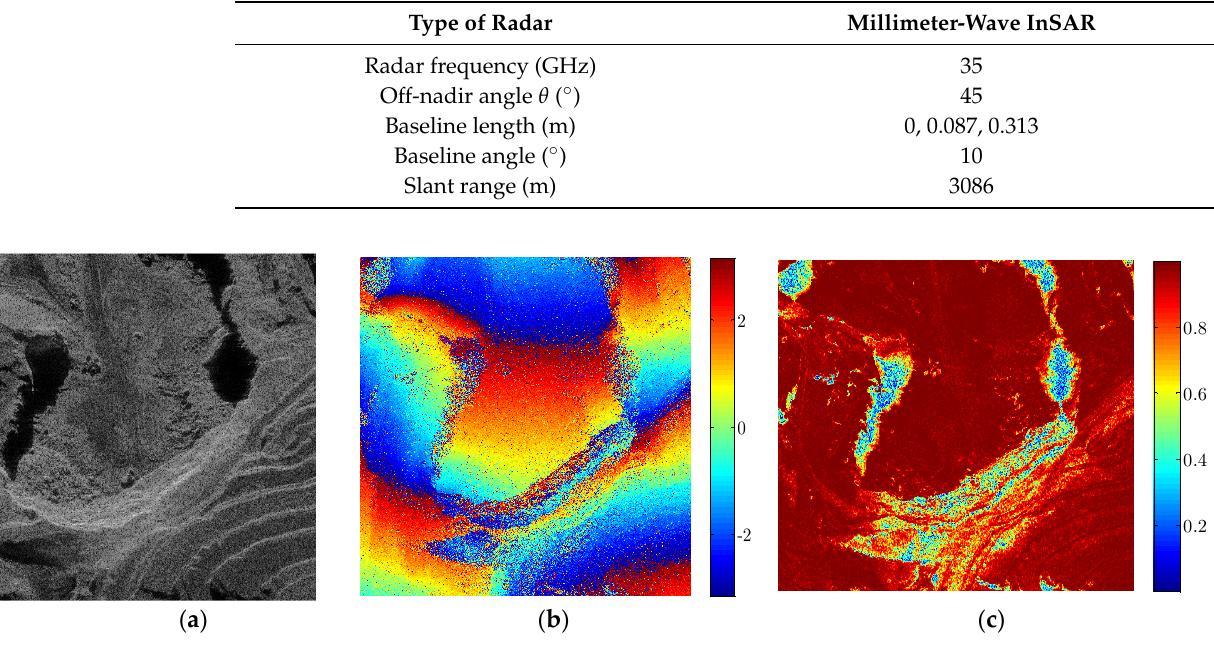
( b ) Figure 4. Number of scattering points. ( a ) Distribution of the number of scatterers, where the hori- zontal axes represent the azimuth direction, and the vertical axes represent the slant range direc- tion.; ( b ) Profile of number of scatterers, the horizontal axes represent pixels from 600 to 800 in the slant range, and the vertical axes represent the number of scatterers in the current pixel. It can be seen from Figure 5 that the sparsity of the results solved by the traditional L1 norm compressive sensing method is significantly weaker than that of the multi-look compressive sensing method. However, it can be seen from Figure 6 that the scatterers solved by the traditional L1 norm compressive sensing method are disorganized and have poor reliability, while the scatterers solved by the multi-look compressive sensing method have a better degree of continuity, which is more consistent with the actual situation and provides higher reliability. Additionally, the difference in height of separated scatterers is